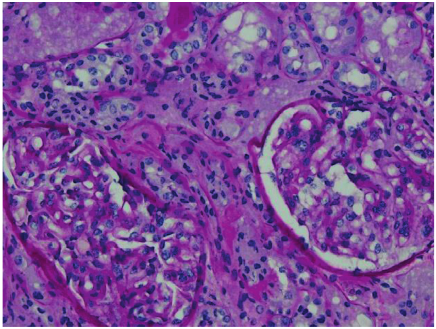
Figure 5: Normal glomeruli